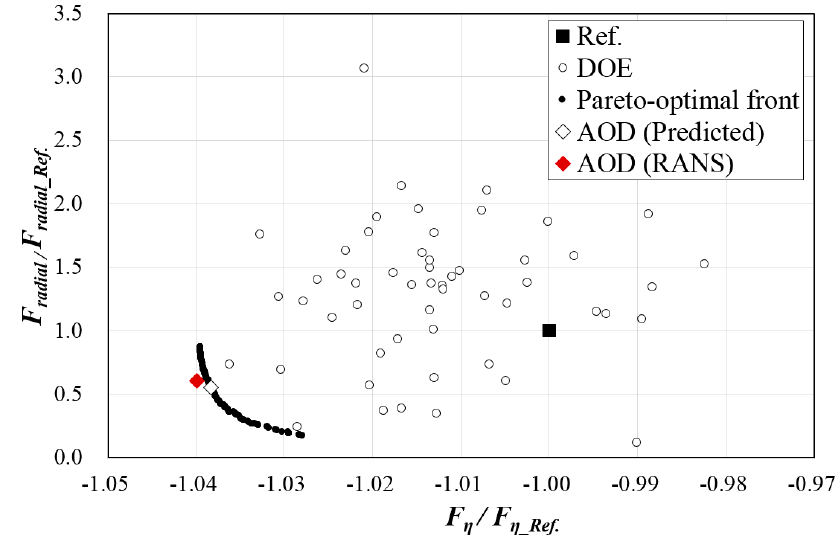
Figure 9. Algorithm of hybrid PSO-GA.